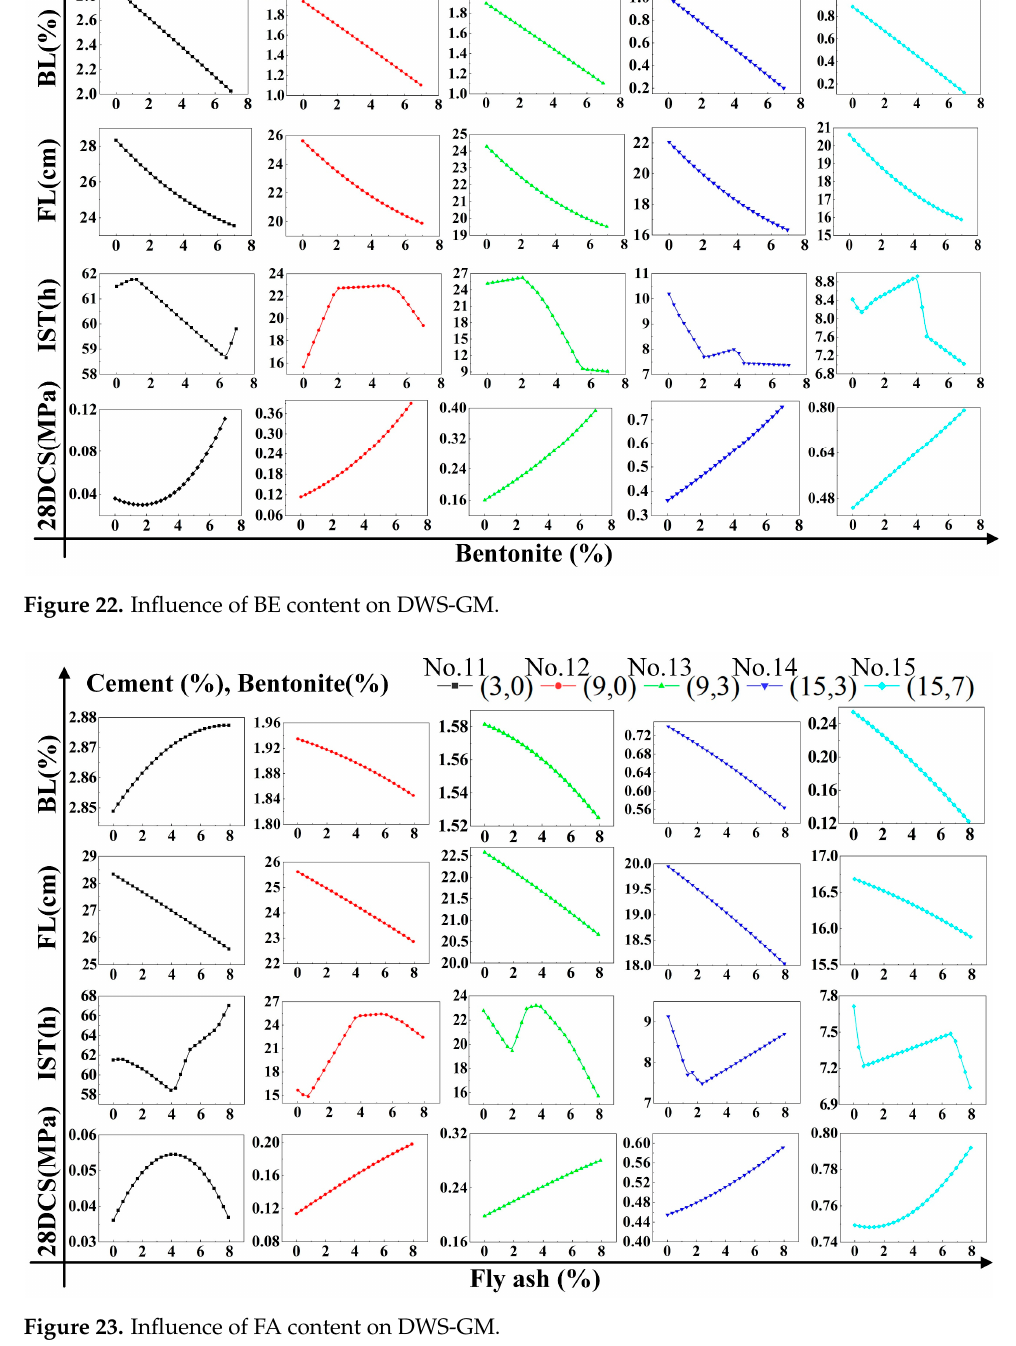
Figure 23. In fl uence of FA content on DWS-GM.